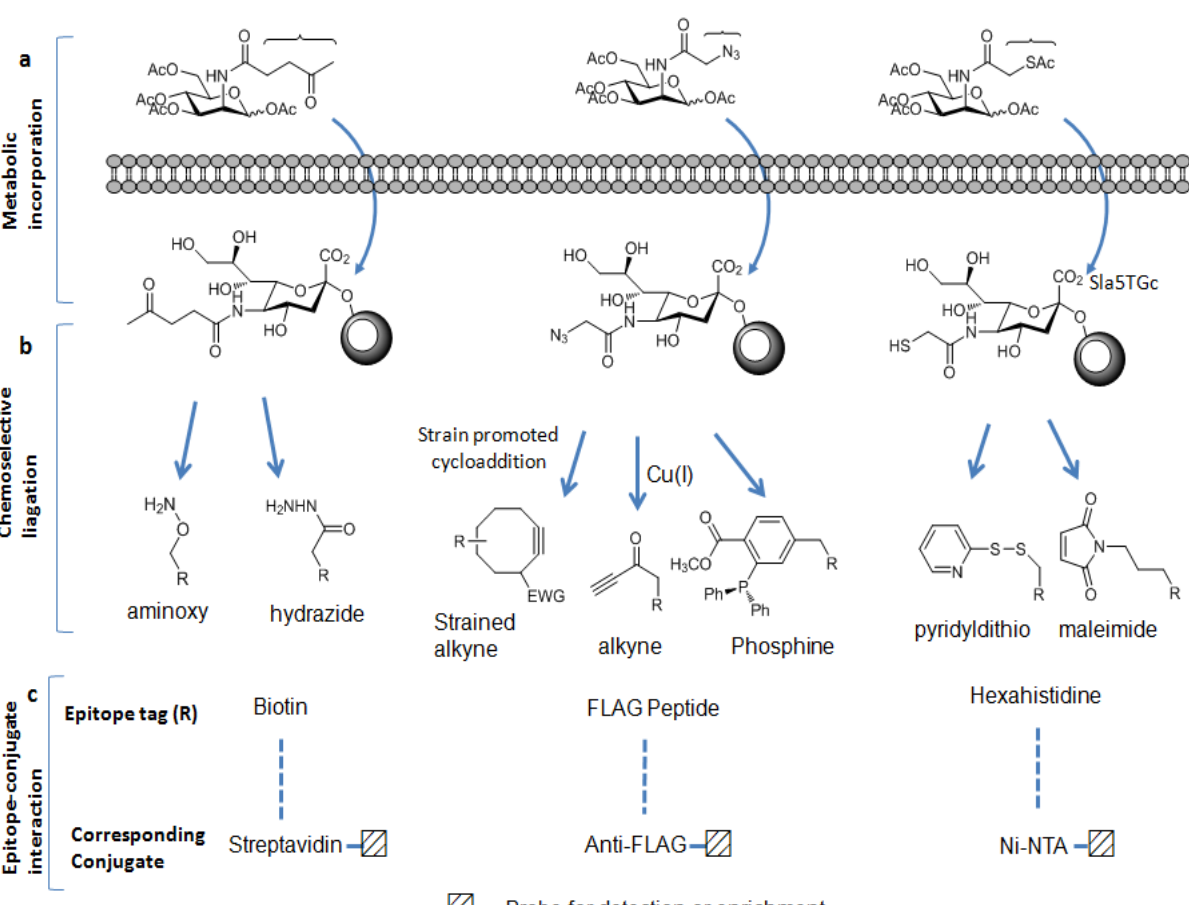
Figure 2. Metabolic labeling carbohydrate-based enrichment strategies: (a) chemical handles can be displayed on the glycoproteins; (b) these chemical handles can be chemoselectively ligated to the appropriate epitope tags; and (c) by the epitopes-conjugates interactions, labeled glycoproteins can be isolated and